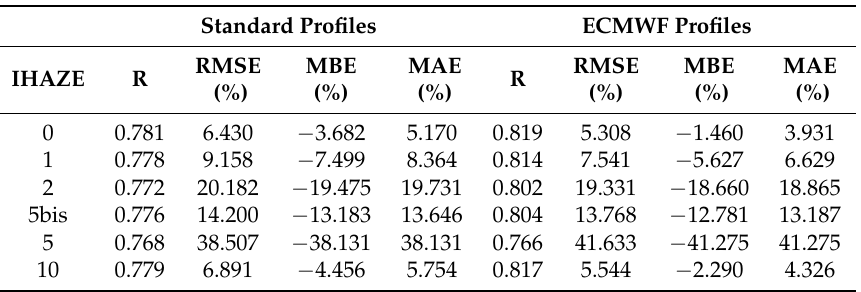
Correlation coefficient (R) and statistical error comparisons between measured and simulated clear-sky downward global solar radiation (DGSR) for six moderate-resolution transmittance (MODTRAN) default aerosol models. Simulations were done with a standard atmosphere and with the insertion of European Center for Medium-Range Weather Forecasts (ECMWF) atmospheric profiles in Maroua in 2014. Root-mean-squared error (RMSE), mean bias error (MBE) and mean absolute error (MAE) are relative values in